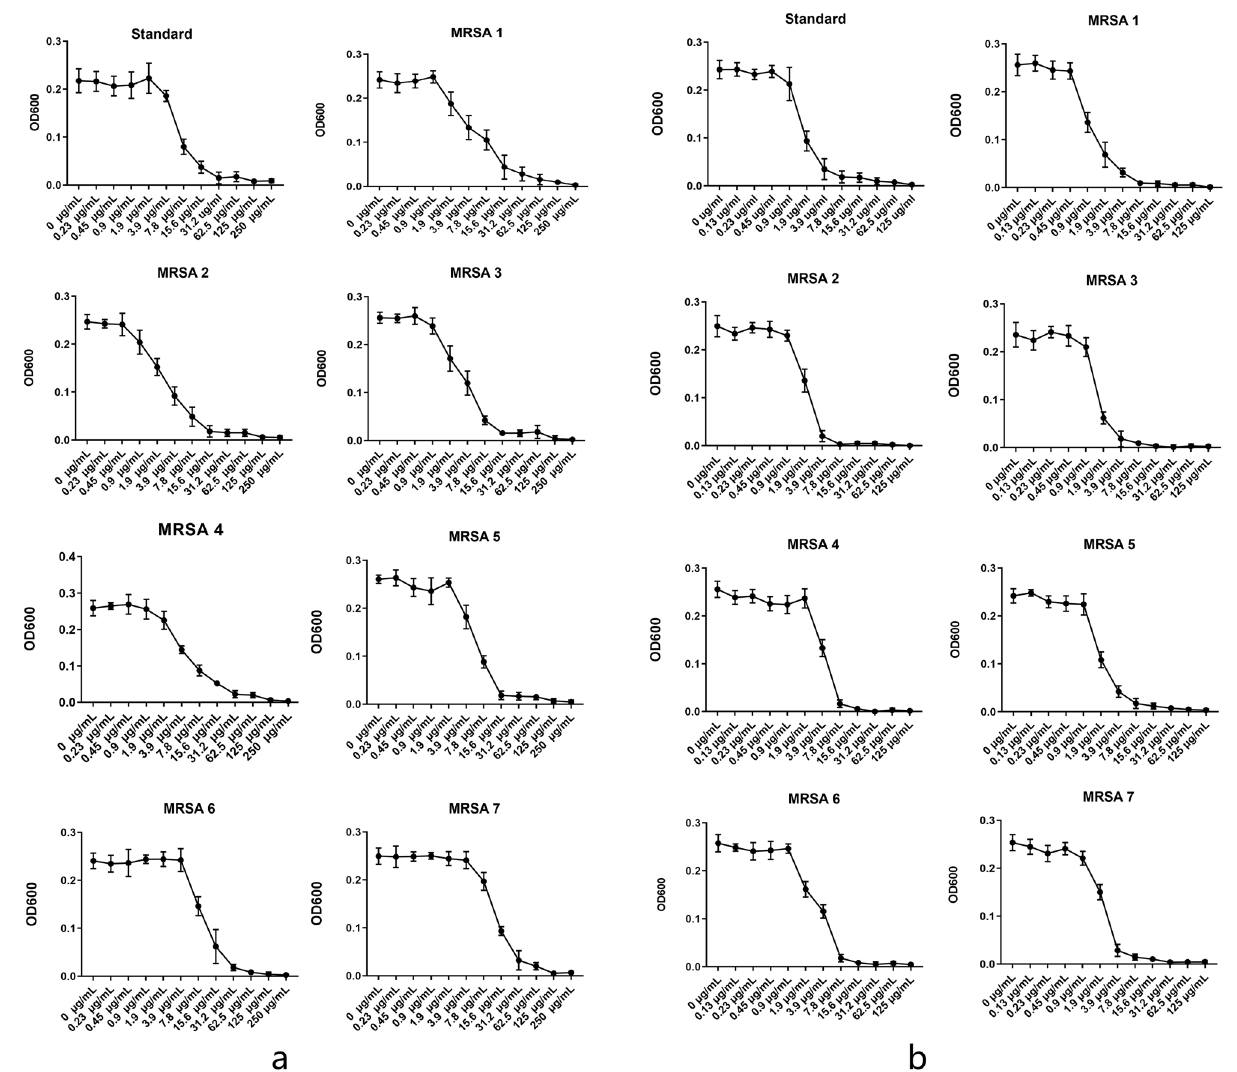
Figure 3. MIC assay of MRSA strains: ( a ) MICs of CT to seven MRSA strains isolated from clinical specimens and standard MRSA strain ATCC 43300; and ( b ) MICs of vancomycin to seven MRSA strains isolated from clinical specimens and standard MRSA strain ATCC